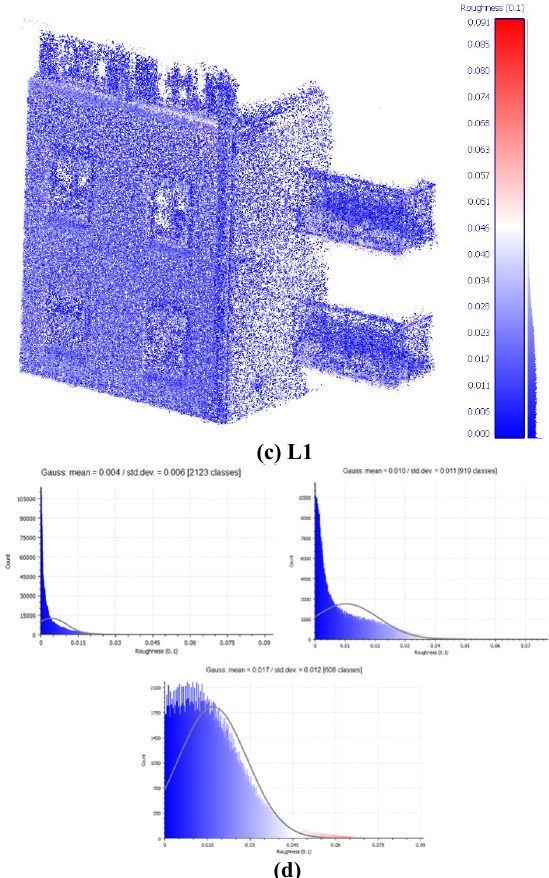
Figure 11. Roughness analyses of the façade section, computed with a radius of 0,1 m. TLS (a) and P1 (b) are used as ground reference and L1 (c) as compared dataset. On the bottom (d), the gaussian distribution for TLS on the top left, P1 on the top right and L1 in the centre.